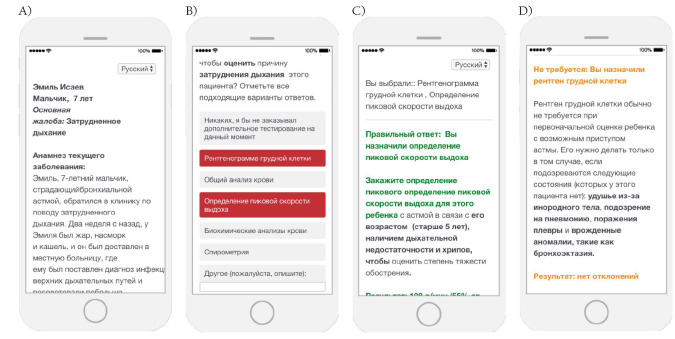
Clinical Performance and Value (CPV) sample screenshots. Panel A. Introduction screen. Panel B. Workup screen. Panel C. Feedback screens.